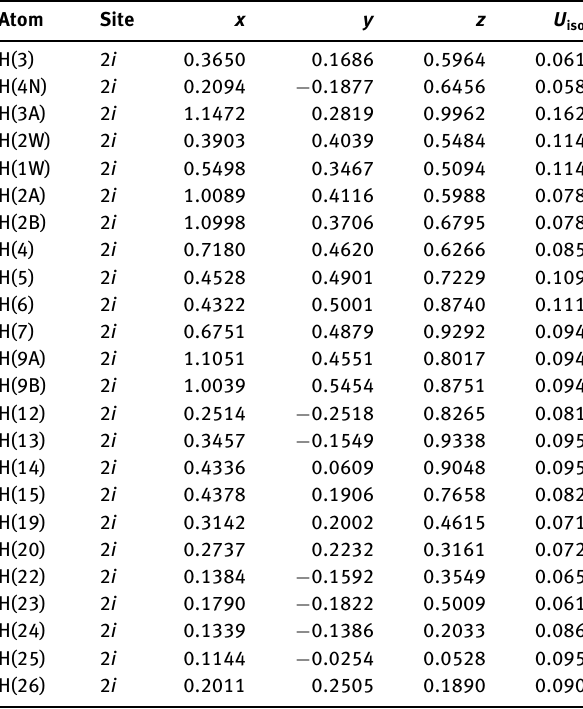
Table 2: Fractional atomic coordinates and isotropic or equivalent isotropic displacement parameters (Å 2